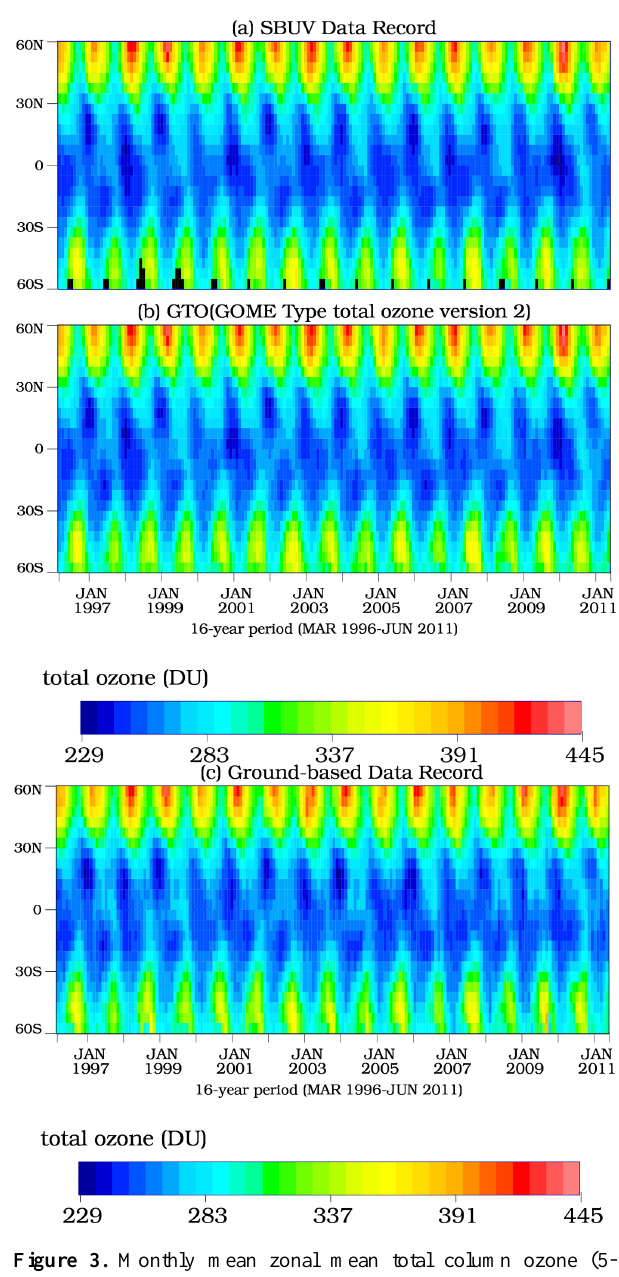
The corresponding standard deviations for satellite- based record versus ground-based record are signifi- cantly larger, ranging between 1.4 and 2.1